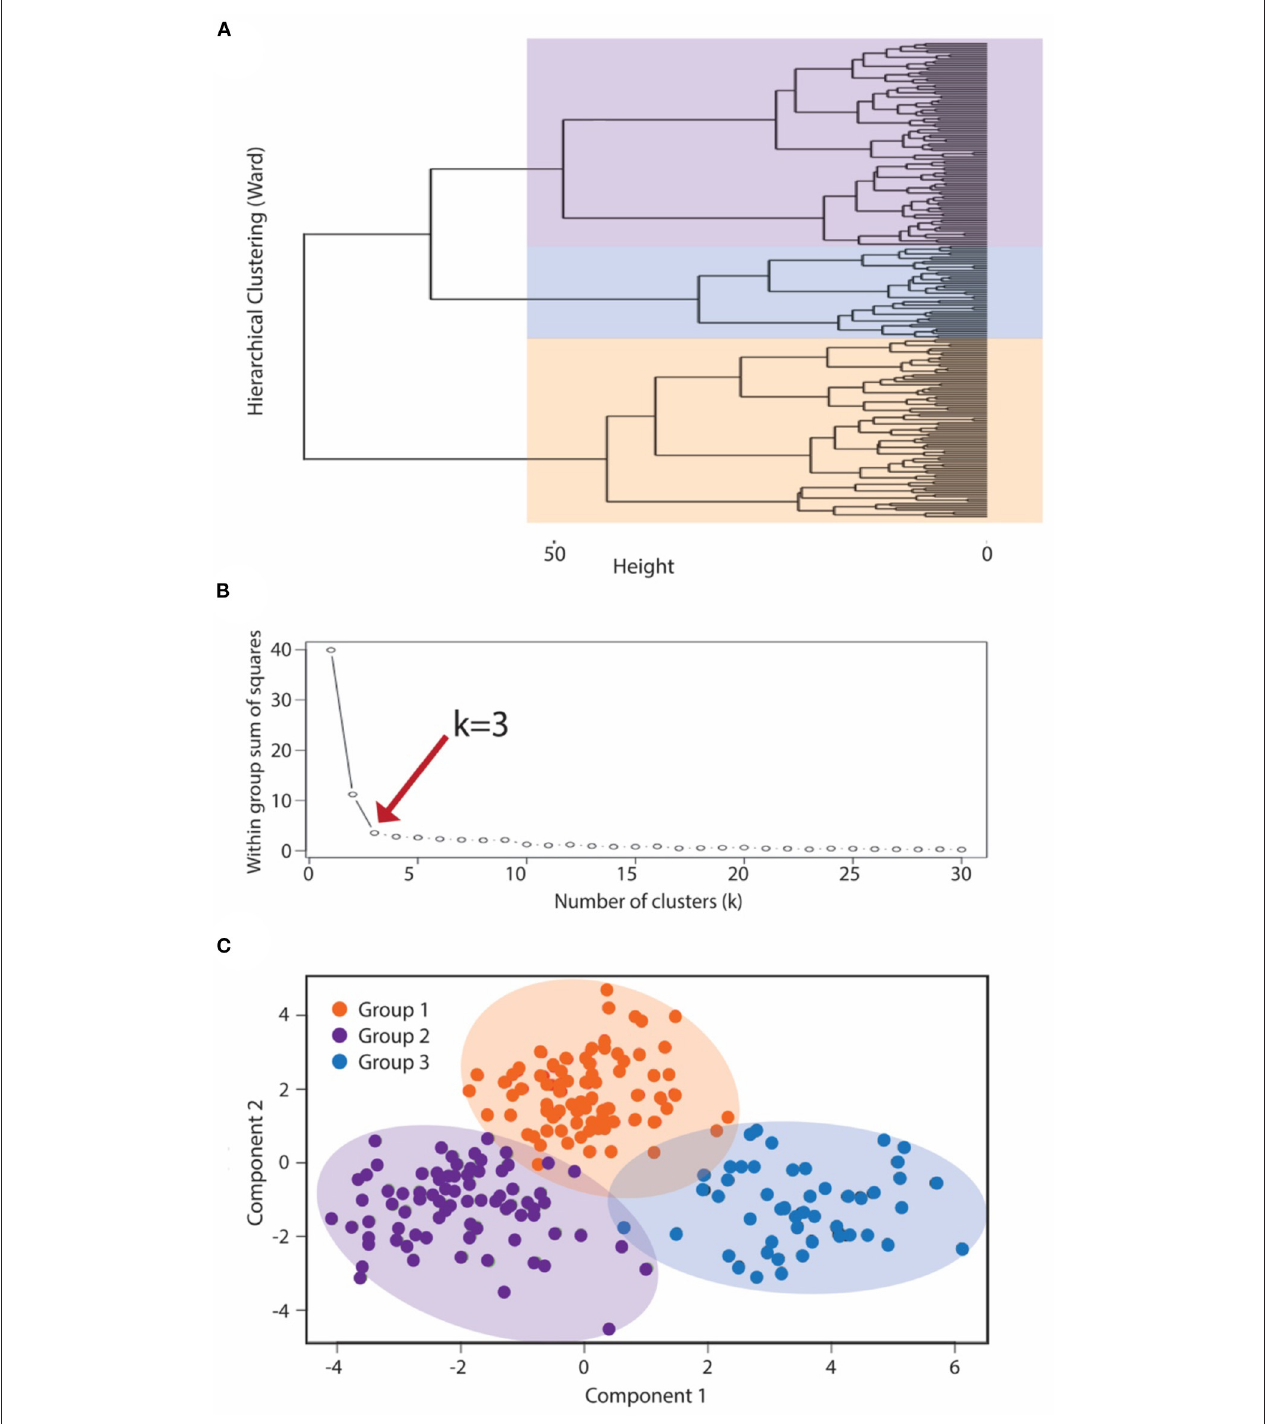
FIGURE 2 | K means clustering to subcategorize pre-menopausal female subjects with IC/BPS. To classify IC/BPS patients into phenotypes, we utilized a k-means algorithm of unsupervised clustering for an independent group of subjects. (A) Dendrogram visualizing the order and distances of subjects for merges during hierarchical clustering by Ward’s method, with the overlaid colors representing the three-group solution as the optimal k . (B) The number of phenotypes (clusters), k, was also determined by the minimum number of groups yielding the most meaningful cluster profiles according to the within group sum of squares method (“elbow” method). (C) Centroid plot for the three-cluster solution by K -means clustering of symptomatic profiles demonstrated clear separation of these clusters into three groups, corresponding to the BPS group (purple), MFP group (orange), and NUPP group